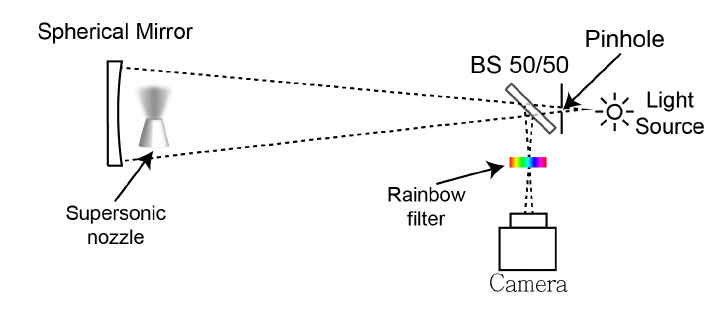
Figure 8. Schematic diagram of our Schlieren